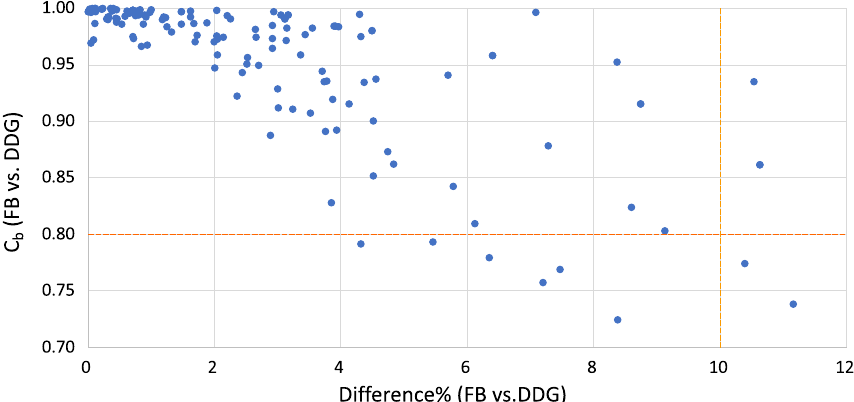
Fig. 2 Distribution of C b and DIFF% comparing radiomics features from DDG and FB